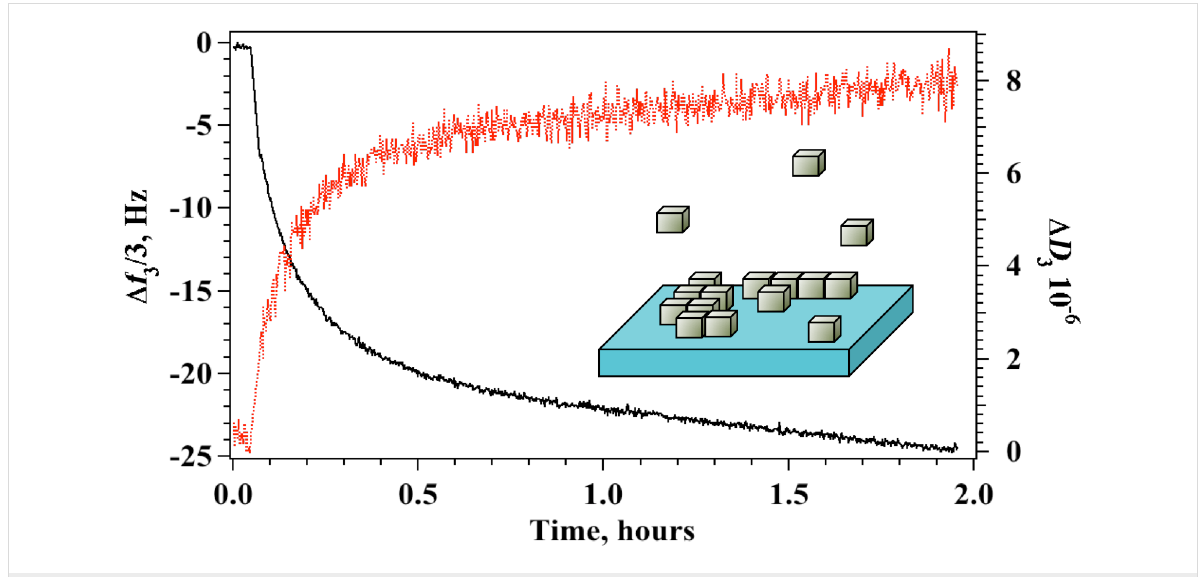
Figure 2: Procedure B. Formation of AgNC arrays by means of sequential physisorption. Δ f 3 /3 (black curve, left axis) and Δ D 3 (red curve, right axis) as a function of time after a single addition of AgNC in the QCM measuring chamber.